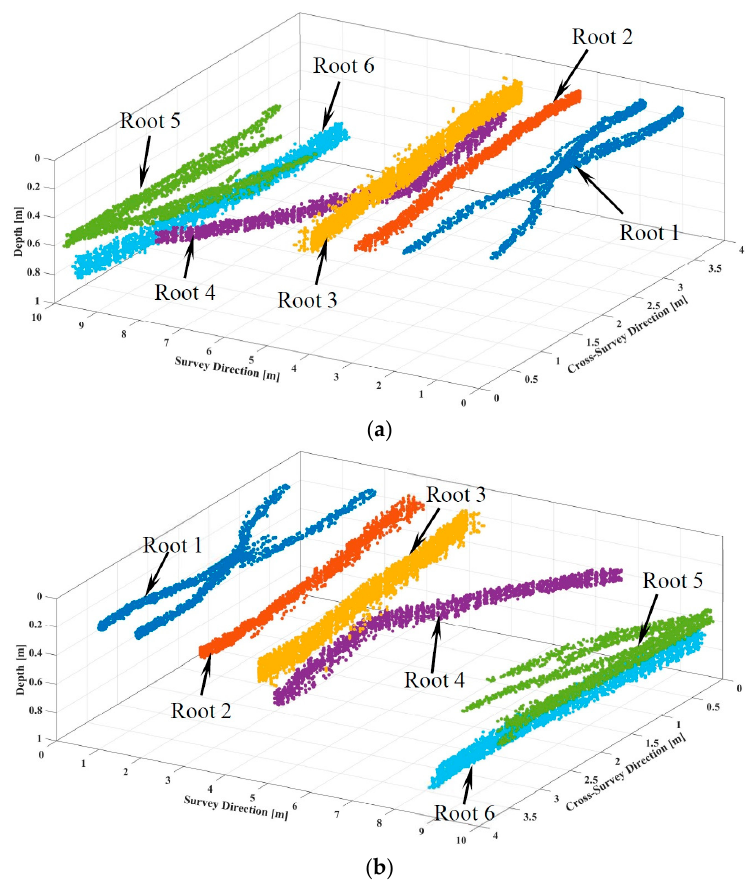
Figure 11. The reconstructed 3D root system: ( a ) View from the starting point; ( b ) view from the ending point.